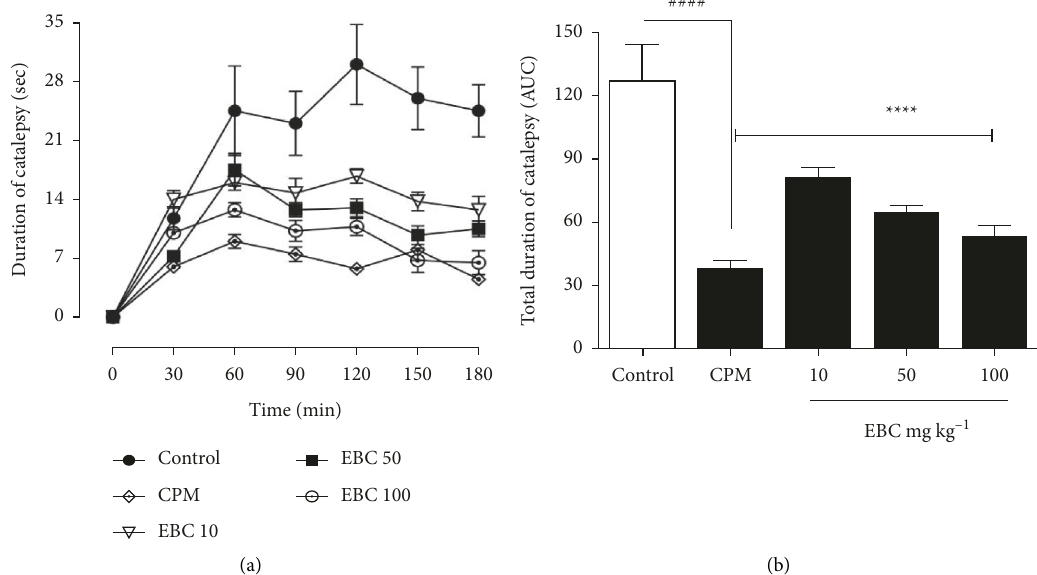
Figure 2: Bombax costatum extract inhibits clonidine-induced catalepsy. Data are presented as Mean chlorpheniramine-treated compared to vehicle-treated; (a) Mean duration of catalepsy. (b) Area under the curve (AUC) of the total duration of